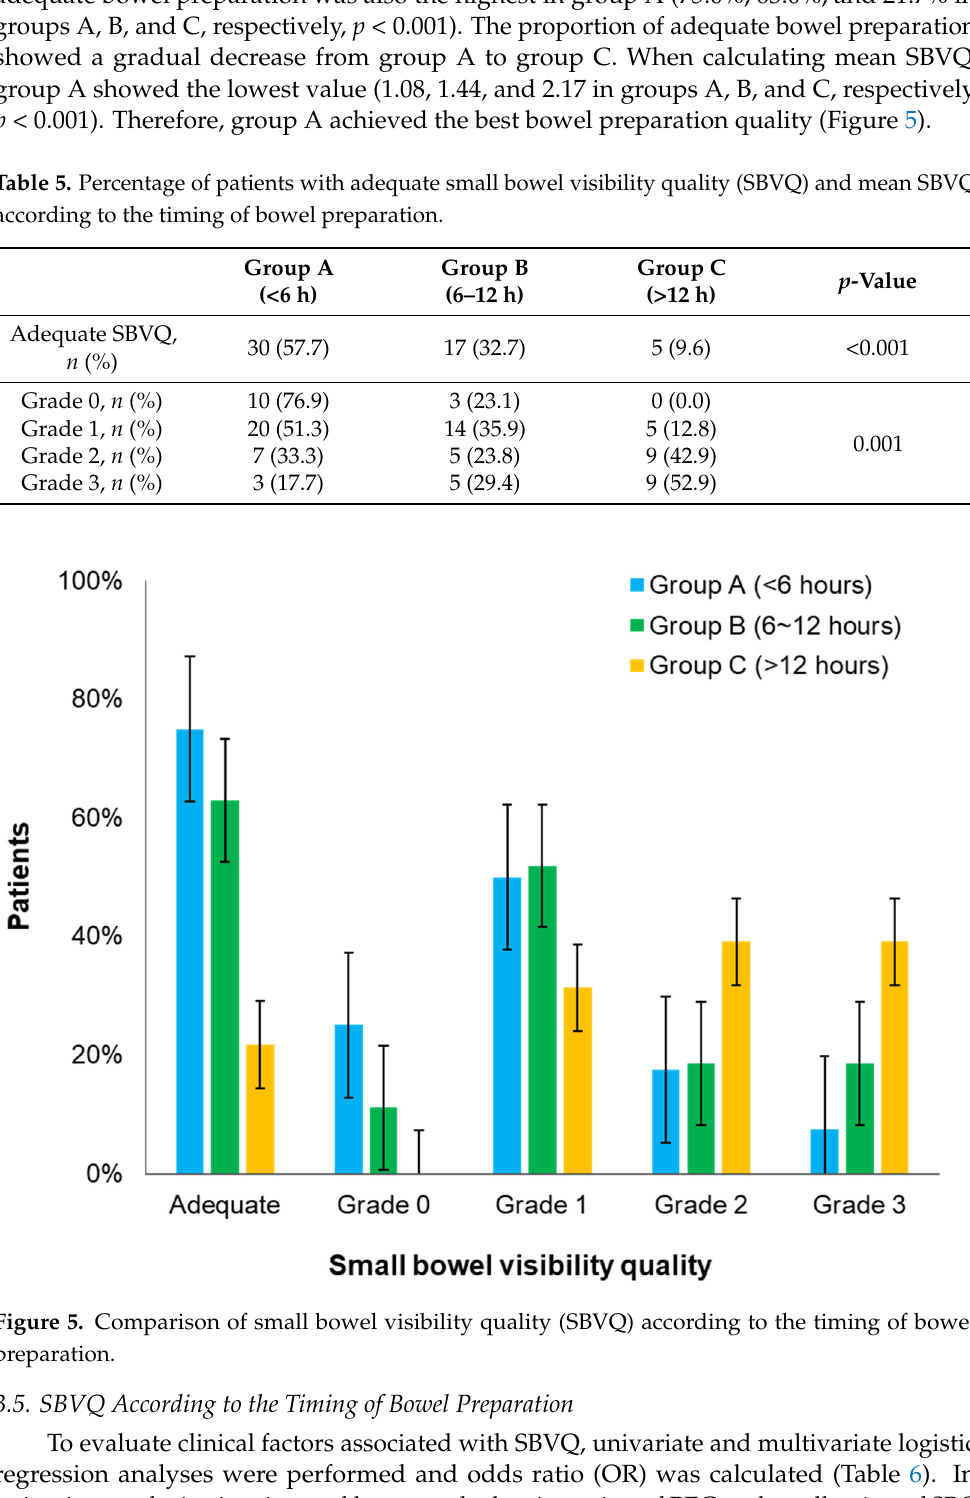
Figure 4. Correlation of the percentage of unclean segment of the small bowel with time interval between the last ingestion of polyethylene glycol and swallowing of the small bowel capsule en- doscope.